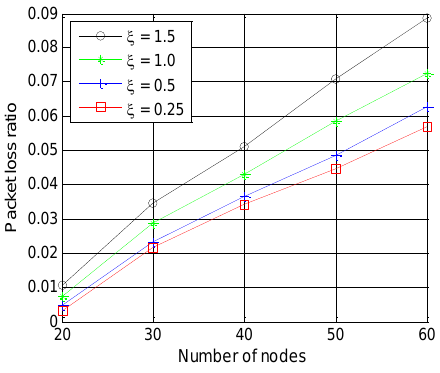
Figure 12. Packet loss ratio vs. number of nodes for different values of ξ